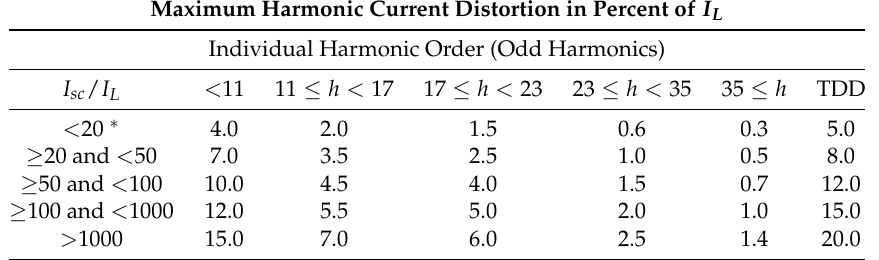
Table 4. Current Distortion Limits for General Distribution Systems (120 V Through 69 kV) [29]. Maximum Harmonic Current Distortion in Percent of I L